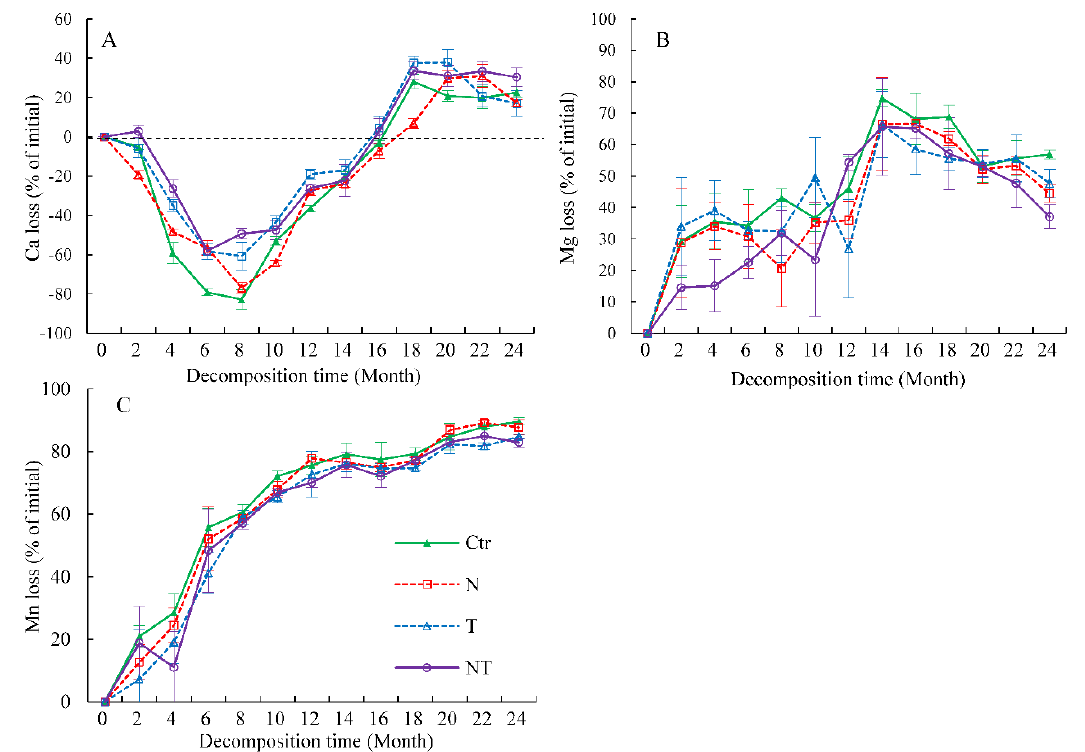
Figure 2. Changes in losses of Ca ( A ), Mg ( B ), and Mn ( C ) in leaf litter exposed in the field during the two-year experiment. Error bars represent the standard deviations of the means ( n = 3). Abbreviations of treatments are given in Figure 1. Table 2. F- and p- values of linear mixed effects models on the effects of nitrogen deposition, throughfall reduction, sam- pling time and their interactions on the loss of Ca, Mg, and Mn during different decomposition stages. Significant effects are given in bold.